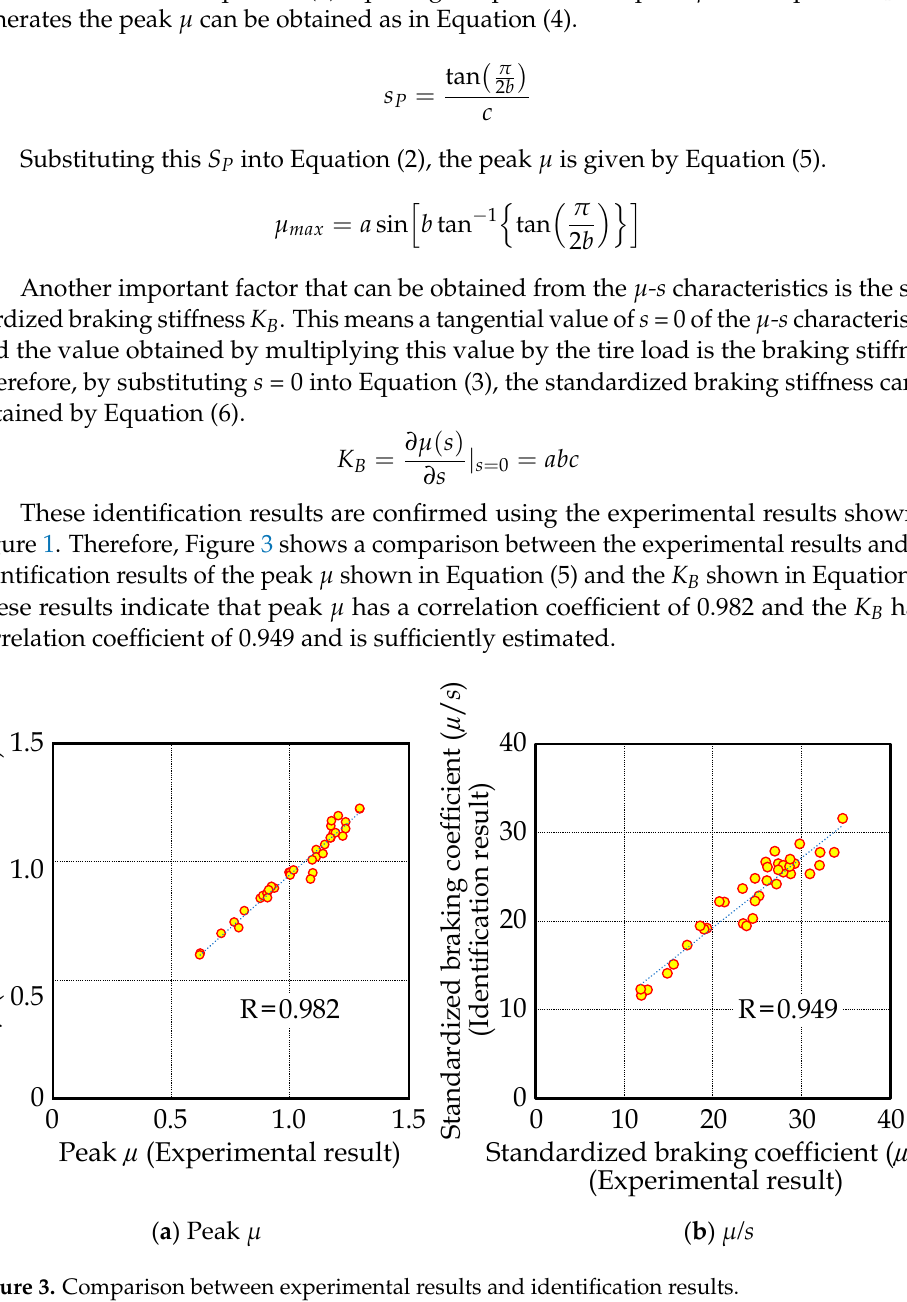
Figure 4. Comparison between experimental results and identification results at lock μ . From Figure 4, the lock μ obtained from the experiment and that from Equation (2) have strong non-linearity, and the value from Equation (2) is smaller in the low μ region. Therefore, when obtaining the μ -s characteristics widely, it is preferable to include an es- timated value of lock μ for identification. Peak μ in these low μ regions occurs at relatively low slip ratios. Past studies show that the reduction in lock μ is relatively large relative to the peak μ that occurs at such low slip ratios. Therefore, we added data on wet roads where the peak μ appears in a region with a low slip ratio, focused on the relationship between the slip ratio and the ratio of lock μ by peak μ , and the obtained results are shown in Figure 5. A logarithmic approximation of this relationship is shown in Figure 5, but